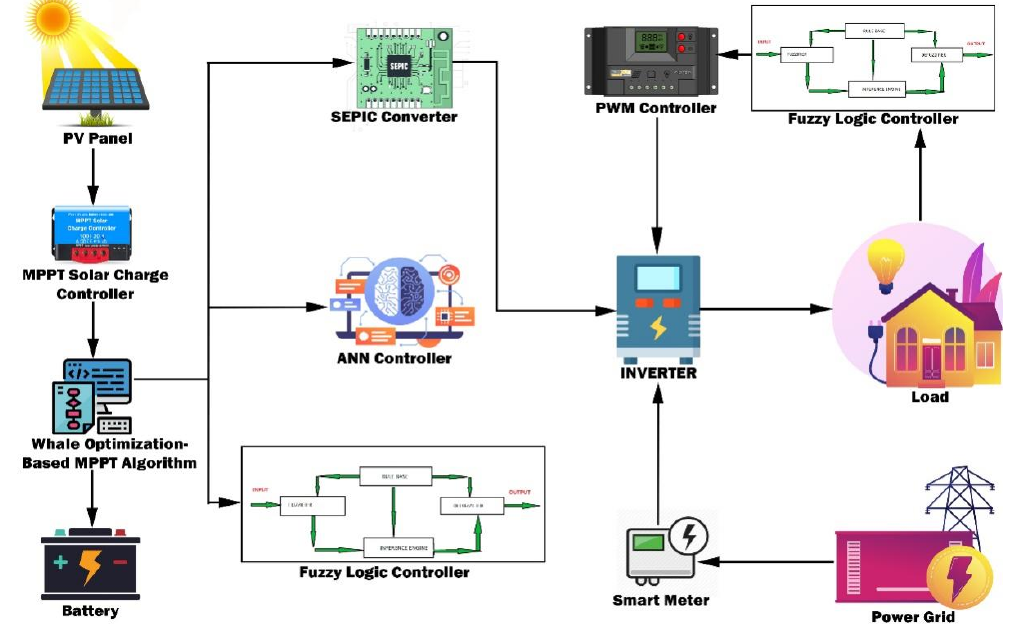
Figure 1. Schematic representation of the implemented methodology